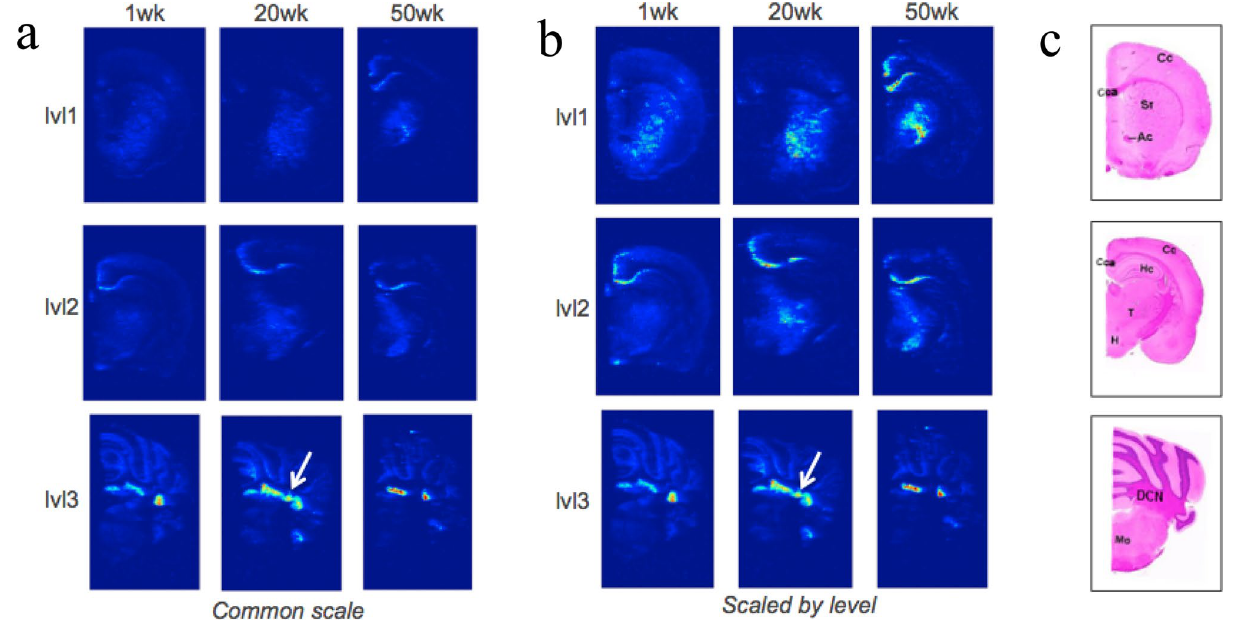
Figure 2. Gadolinium distribution in the rat brain after a cumulative gadodiamide dose. Gadolinium distribution is consistent over a 1-year period following a cumulative dose of 12 mmol/kg over 5 weeks (n = 3 per group), with the highest concentration in the DCN. Localization of gadolinium across the brain measured by LA-ICP-MS. ( a ) representative images from each brain level and each treatment group on a common scale—the highest concentration of gadolinium is observed in the DCN in level 3 (arrow, bottom row). ( b ) The same images with each level exhibited on a different scale to highlight areas of gadolinium in each. ( c ) Example H&E images of the same levels with major features marked (levels are defined as (1) cerebrum at the optic chiasm, (2) cerebrum at the base of the posterior hypothalamus (3) mid-cerebellum and medulla oblongata). Ac anterior commissure, Cc cerebral cortex, Cca corpus callosum, DCN deep cerebellar nuclei, Hc hippocampus, H hypothalamus, Mo medulla oblongata, Sr striatum, T